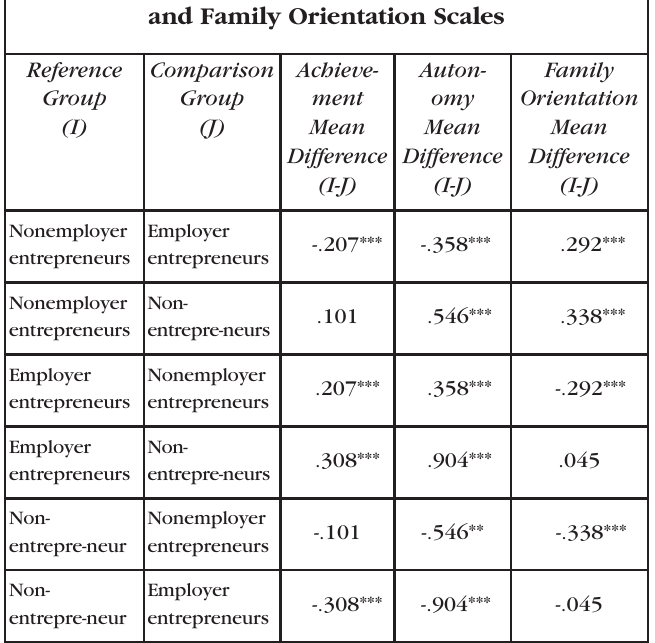
Table 2. Results of Bonferroni Tests of Differences for the Autonomy, Achievement,